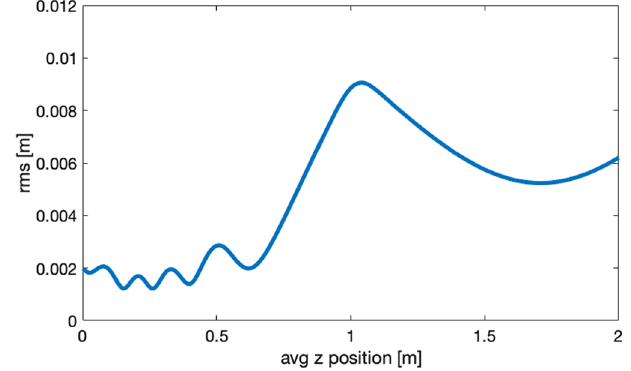
FIG. 7. Transverse rms beam size evolution from cathode to 1D pepper-pot.